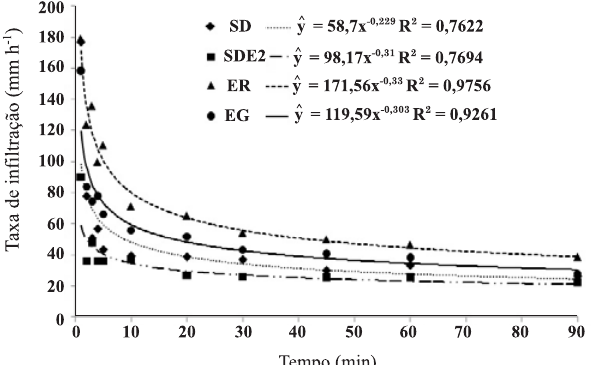
Figura 3. Taxa de infiltração de água nos diferentes sistemas de preparo de solo. SD: Semeadura